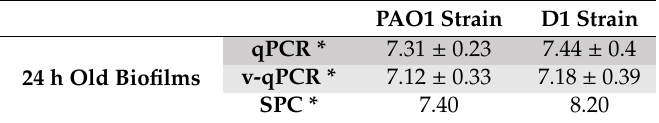
Table 7. Relative cell quantification of 24 h old biofilms.